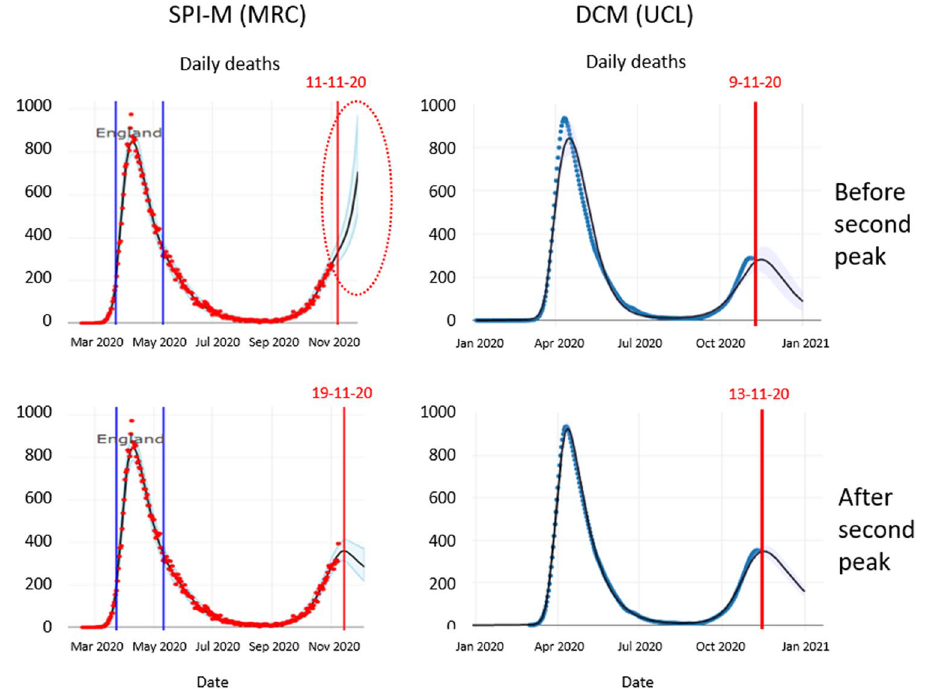
Figure 4. Predicting the second peak: The left panels show the forecasts from the MRC Biostatistics Unit at the University of Cambridge, UK, shortly before and after the peak of a second surge. These projections were taken as screen grabs from the dashboard on appropriate days. The right panels show the equivalent predictions using dynamic causal modelling. The top row shows the predictions before the second peak, while the bottom row shows the equivalent predictions a few days later. The dates are indicated by the vertical red lines. The red ellipse highlights an example of overfitting recent trends in the data.